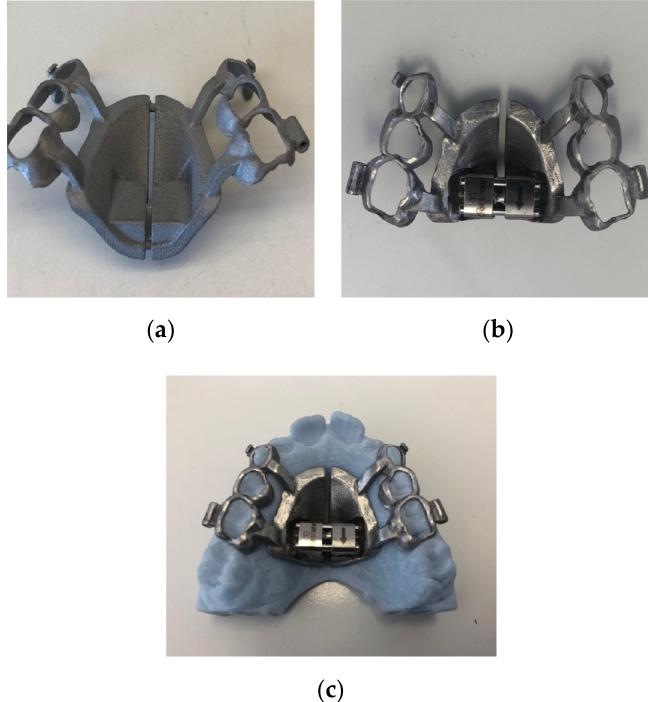
Figure 3. ( a ) “Rough” structure before “post printing process". ( b ) External polishing of the device. ( c ) Checking the device on the model.